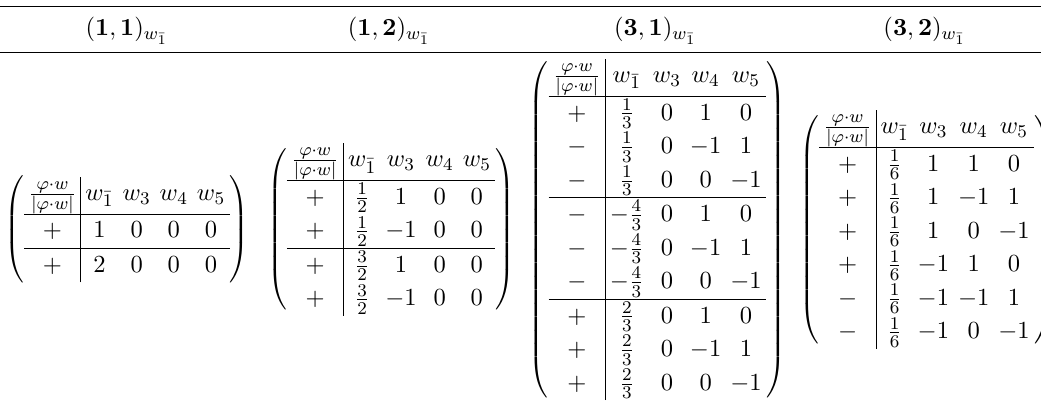
Table 7 . Signs and Cartan charges associated to the BPS spectrum of the (SU(3) × SU(2) × U(1)) / Z 6 model resolution eq. (3.10). The charges are the Dynkin coefficients w of the weights w transforming i in various representations and the signs correspond to the signs of the BPS central charges ϕ · w for a given choice of Coulomb branch moduli ϕ i . The indices i of the Dynkin coefficients are chosen to match the indices of the Cartan divisors ˆ D in eq. (7.10) associated to the simple coroots of the i gauge group. We adopt the convention that the Coulomb branch modulus ϕ ¯1 dual to the u (1) factor is non-positive in the Coulomb branch, in contrast to the Coulomb branch moduli ϕ i 2 =3 , ϕ i 3 =4 , 5 associated to nonabelian Cartan u (1) s, which are